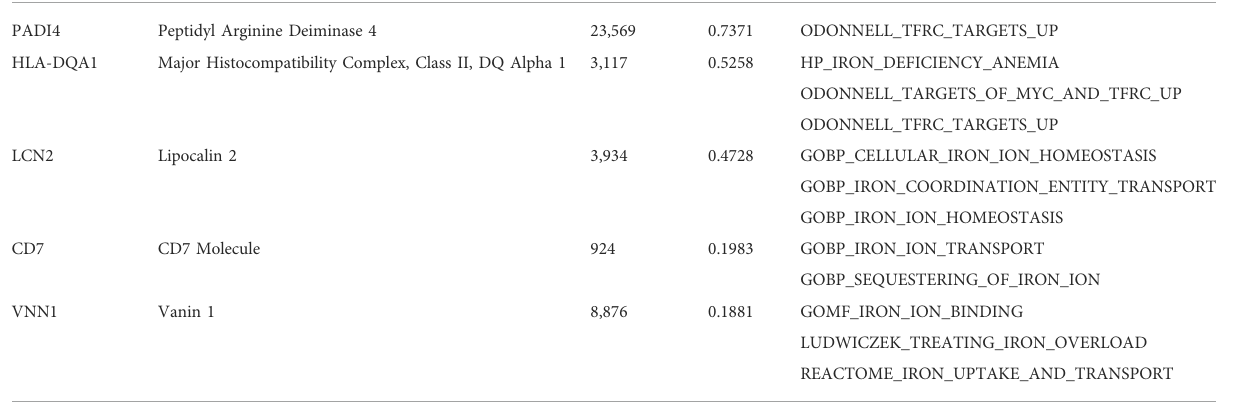
TABLE 1 Determined genes in imSig.